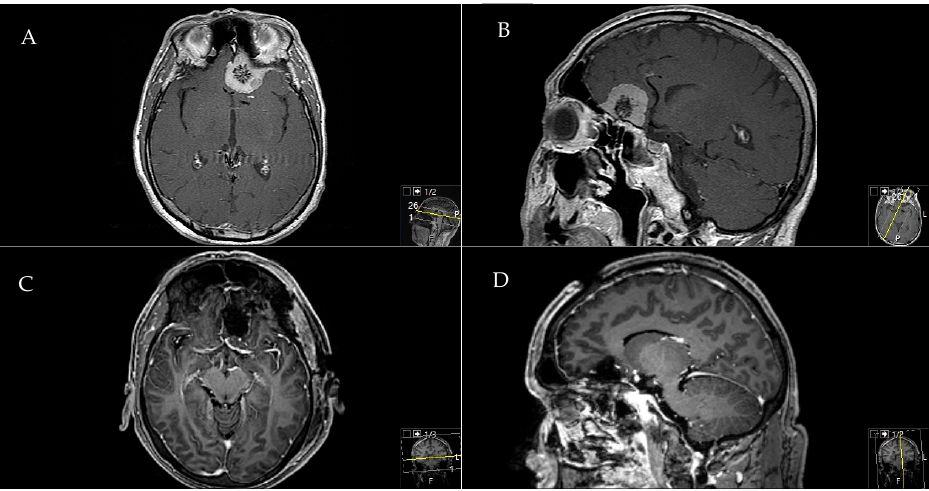
Figure 5. Exemplary case of a calcified PSM.